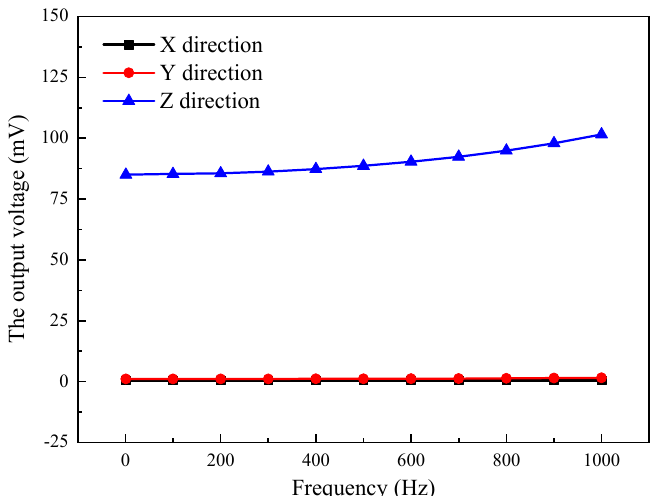
Figure 5. The output voltage curves of the model when vibrated in different directions.